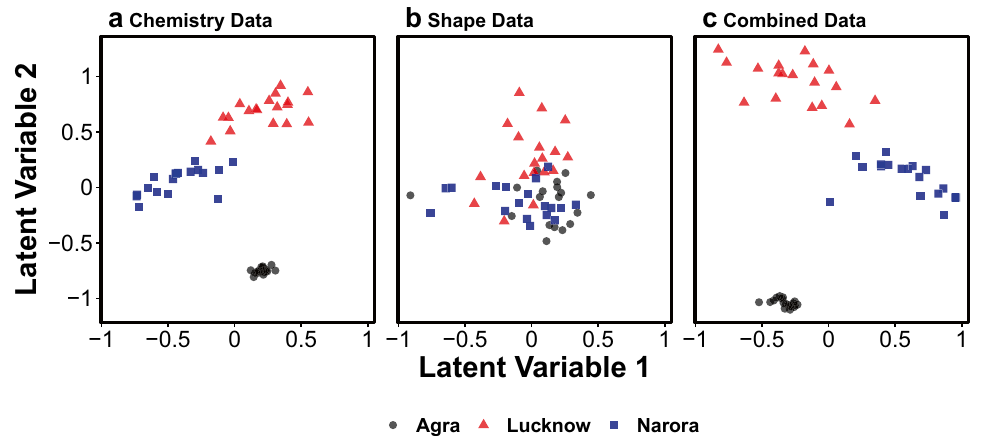
Figure 6. Model-based latent variable ordinations of ( a ) the otolith chemistry dataset, ( b ) the otolith shape dataset, and ( c ) the combined otolith chemistry and shape dataset. Colours and shapes represent the three groups of C. striata